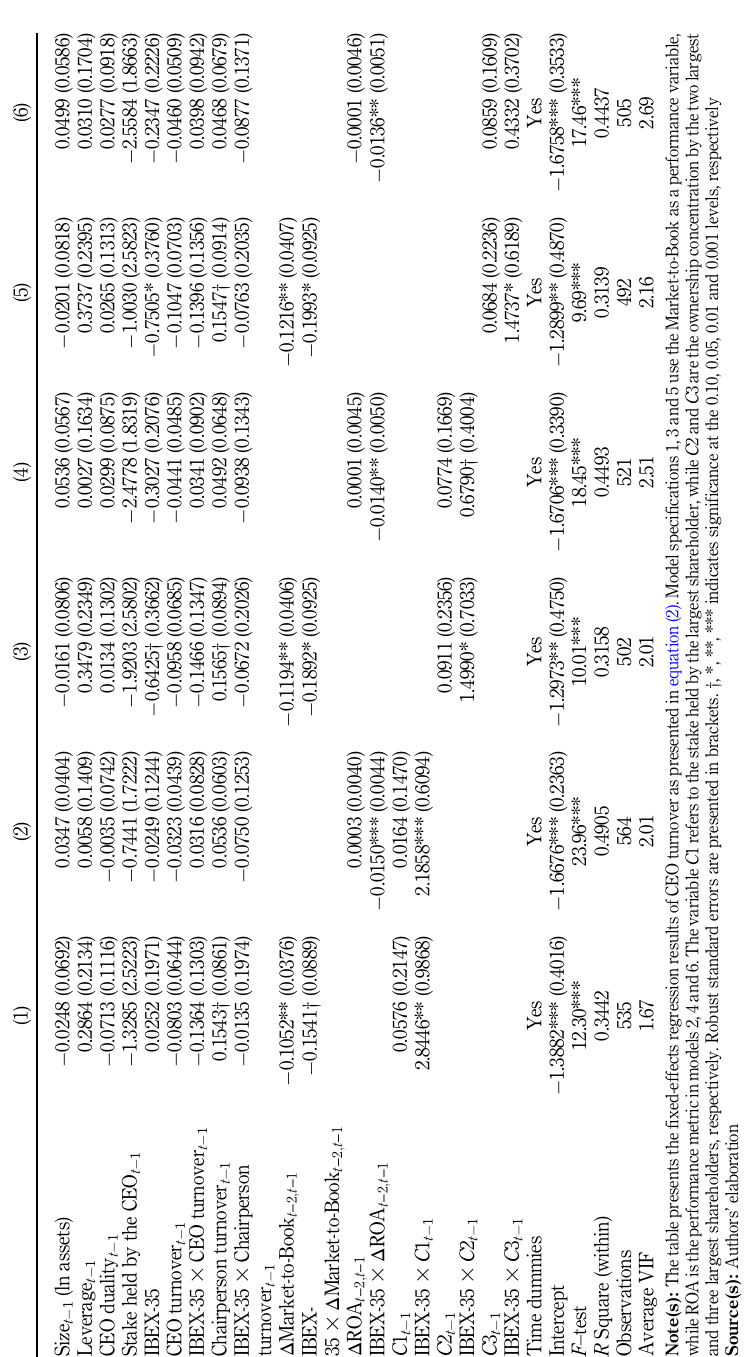
Table 6. CEO turnover: the alignment of shareholders in public